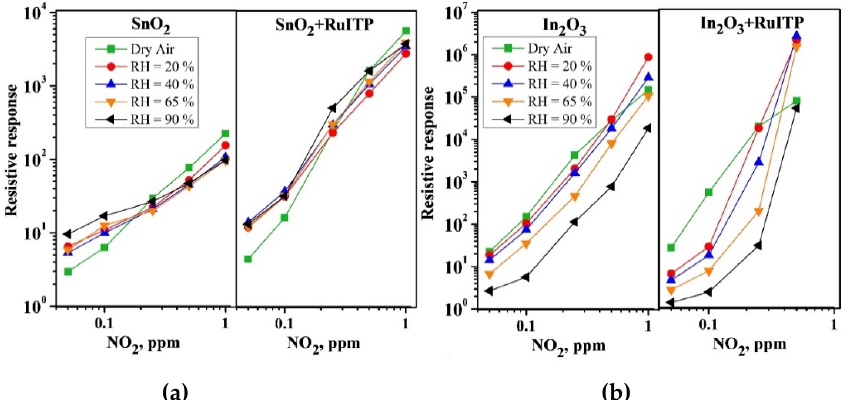
Figure 3. Resistive response of ( a ) SnO 2 , SnO 2 +RuITP and ( b ) In 2 O 3 , In 2 O 3 +RuITP samples depending on NO 2 concentration in dry and humid air at room temperature.